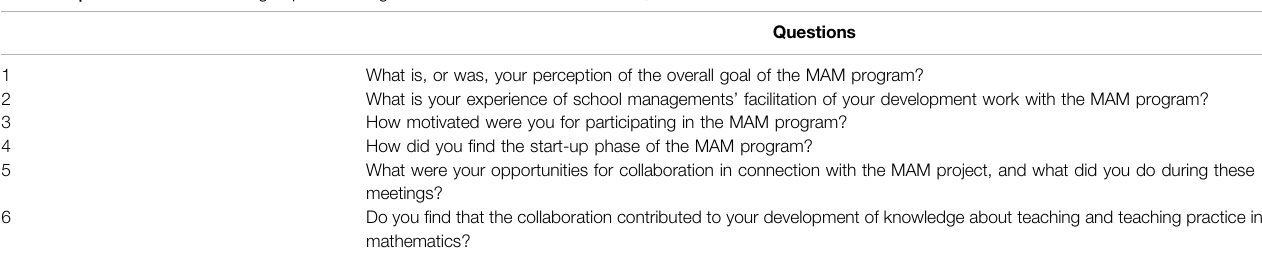
TABLE 4 | Structure of the focus-group interview guide for the mathematics teachers, fall